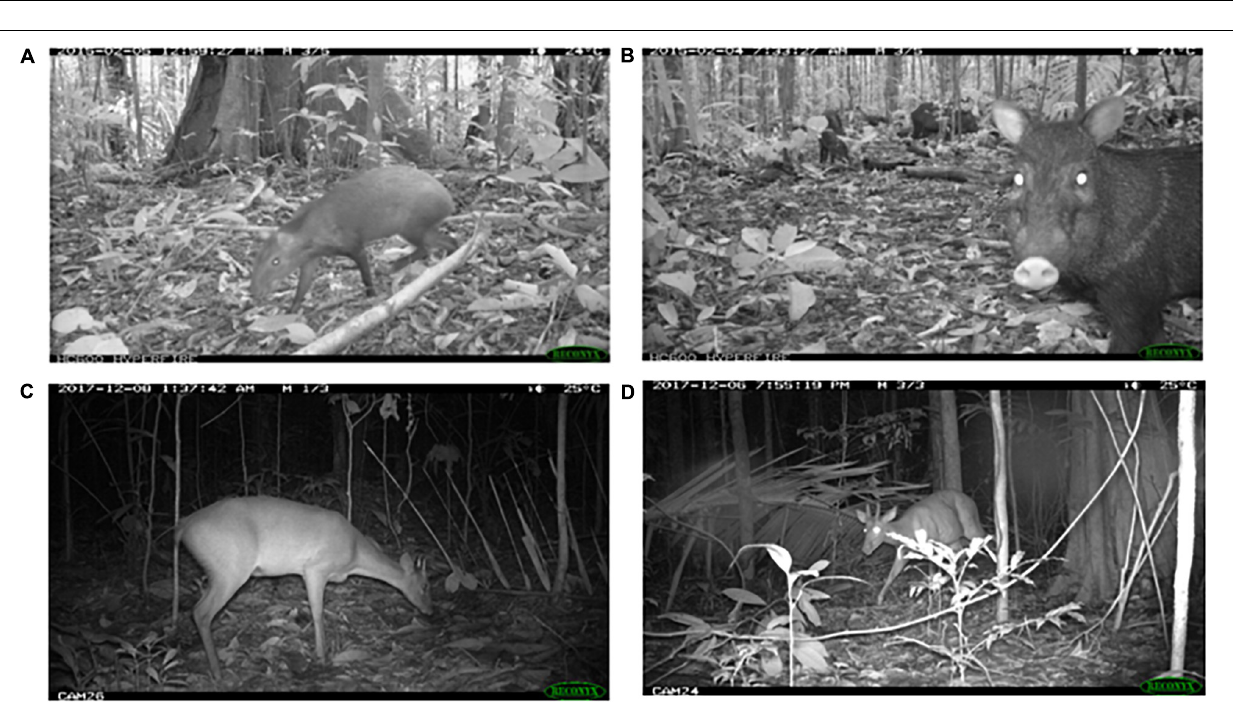
df = 1, P = 0.14 and X 2 = 2.15, df = 1, P > 0.05, respectively). The proportion of Virola fruits found as single valves and seed removal rate did not differ between forest patches ( X 2 = 0.73,